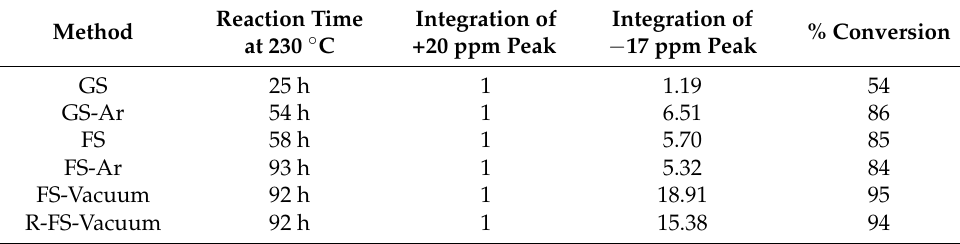
Table 2. Comparison of different methods to synthesize PDCP.